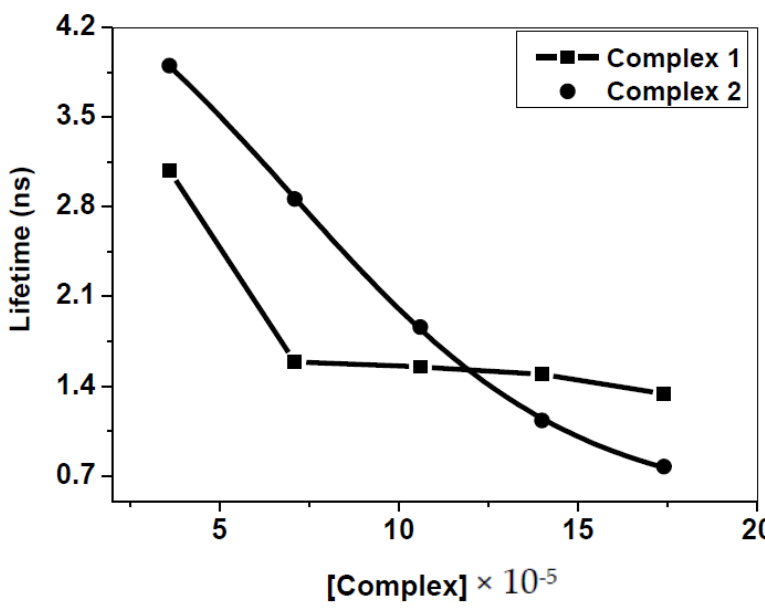
Figure 4. A plot of lifetime decay (ns) of BSA (36 µ M) versus concentration of zinc complexes.